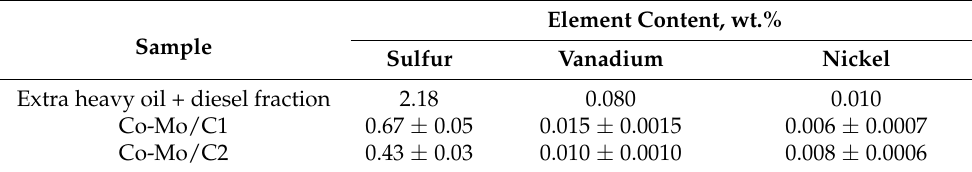
Table 5. Sulfur, vanadium and nickel content in feedstock and reaction